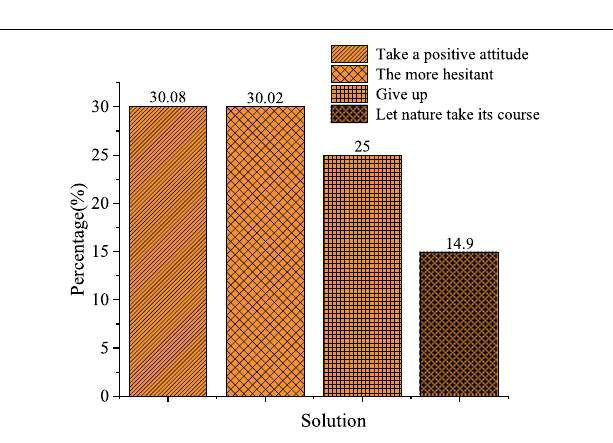
FIGURE 3 | Solutions against entrepreneurial